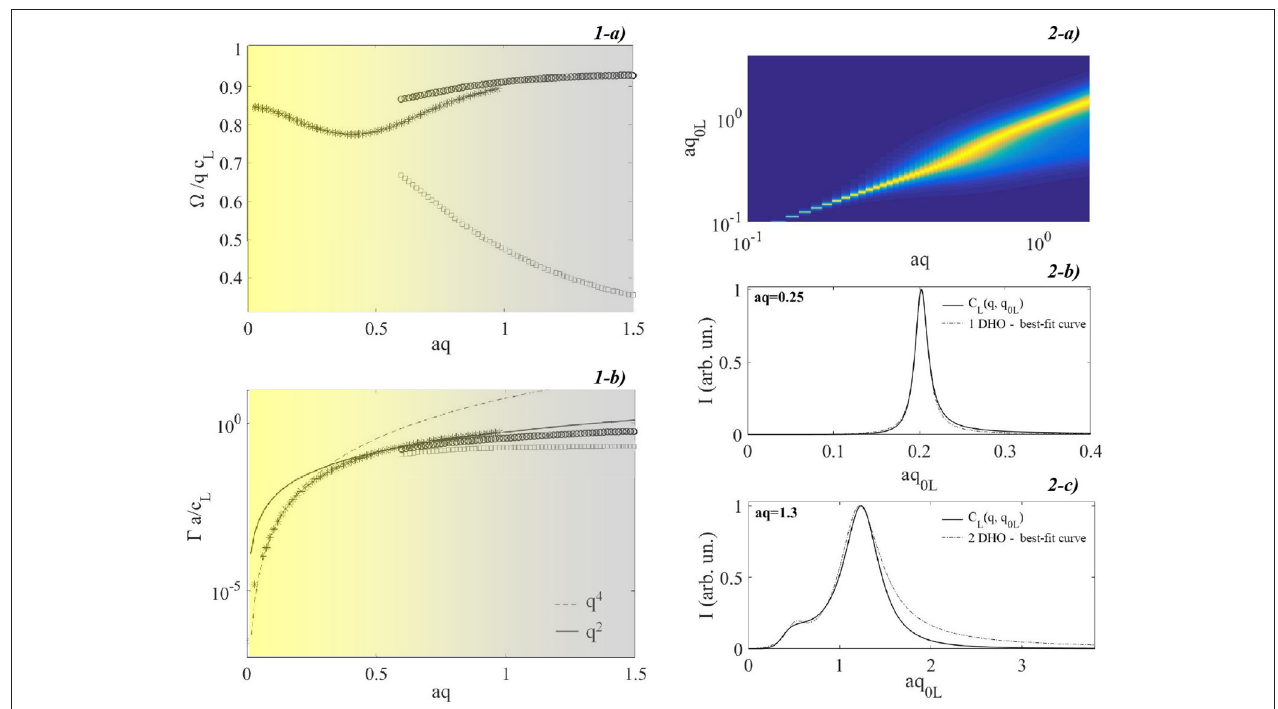
FIGURE 7 | Features of the longitudinal acoustic dynamics obtained by exploiting the GBA both in the Rayleigh region, aq << 1 and in the wavevectors region aq ∼ 1 where the mixing of polarizations shows up. (1-a) . Adimensional phase velocity (cid:127)/ qc L as a function of aq . Stars represent outcomes from 1-DHO model fitting, circles and squares represent outcomes from 2-DHO model fitting related respectively to high- and low-frequency features. (1-b) Adimensional attenuation Ŵ a / c L as function of aq . The meaning of the symbols is the same of (1-a) . Full black line and dashed line are guide to eye displaying respectively the q 4 and q 2 trend. (2-a) Projection on the ( aq , aq 0 L ) plane of the longitudinal currents. (2-b) Representative longitudinal current spectrum in the Rayleigh region (full black line). The dashed line shows the best-fit curve with a 1-DHO fitting model. (2-c) Representative longitudinal current spectrum in the wavevector region where the mixing of polarizations is clearly observable (full black line). The dashed line shows the best-fit curve with a 2-DHO fitting model.